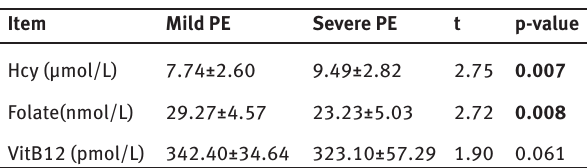
Table 3: Maternal Serum Homocysteine, Folate and vitamin B12 level in PE